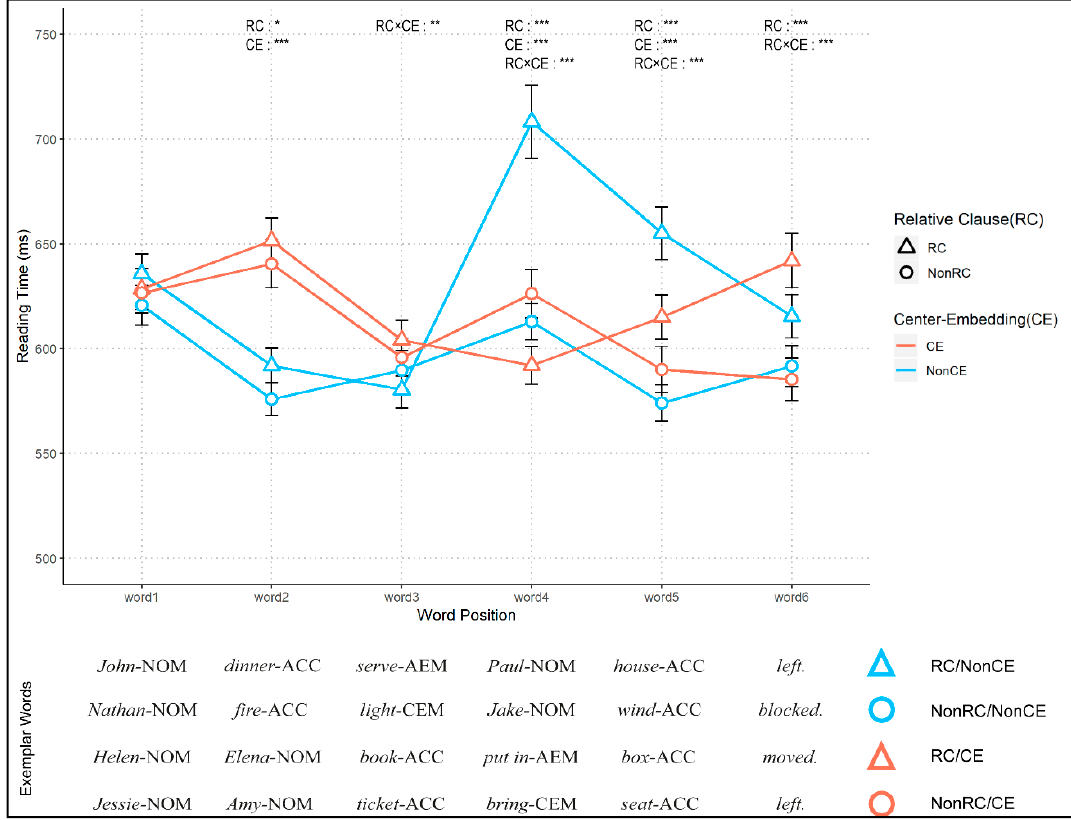
Figure 2. Reading-time data from the self-paced reading task in Experiment 1. The mean reading times with standard deviations are depicted for all the conditions. The x-axis indicates the position of words presented, and the y-axis denotes the reading times in milliseconds (ms). The triangular data points depict the RC condition, while the circular data points depict the non-RC (NonRC) condition. Blue and orange lines indicate non-CE (NonCE) and CE conditions, respectively. The significant effects from two-by-two linear mixed-effect analyses are shown at the top of each word position (For details, see Table 3). Exemplar words labeled with four conditions (i.e., RC / NonCE, NonRC / NonCE, RC / CE, NonRC / CE) are presented at the bottom. Abbreviations: RC (the main effect of a relative clause), CE (the main effect of center embedding), RC × CE (an interaction between the relative clause and center embedding), AEM (adnominalizing ending marker), CEM (conjunctive ending marker), NOM (nominative case marker), ACC (accusative case marker). (* = p < 0.05, ** = p < 0.01, *** = p <